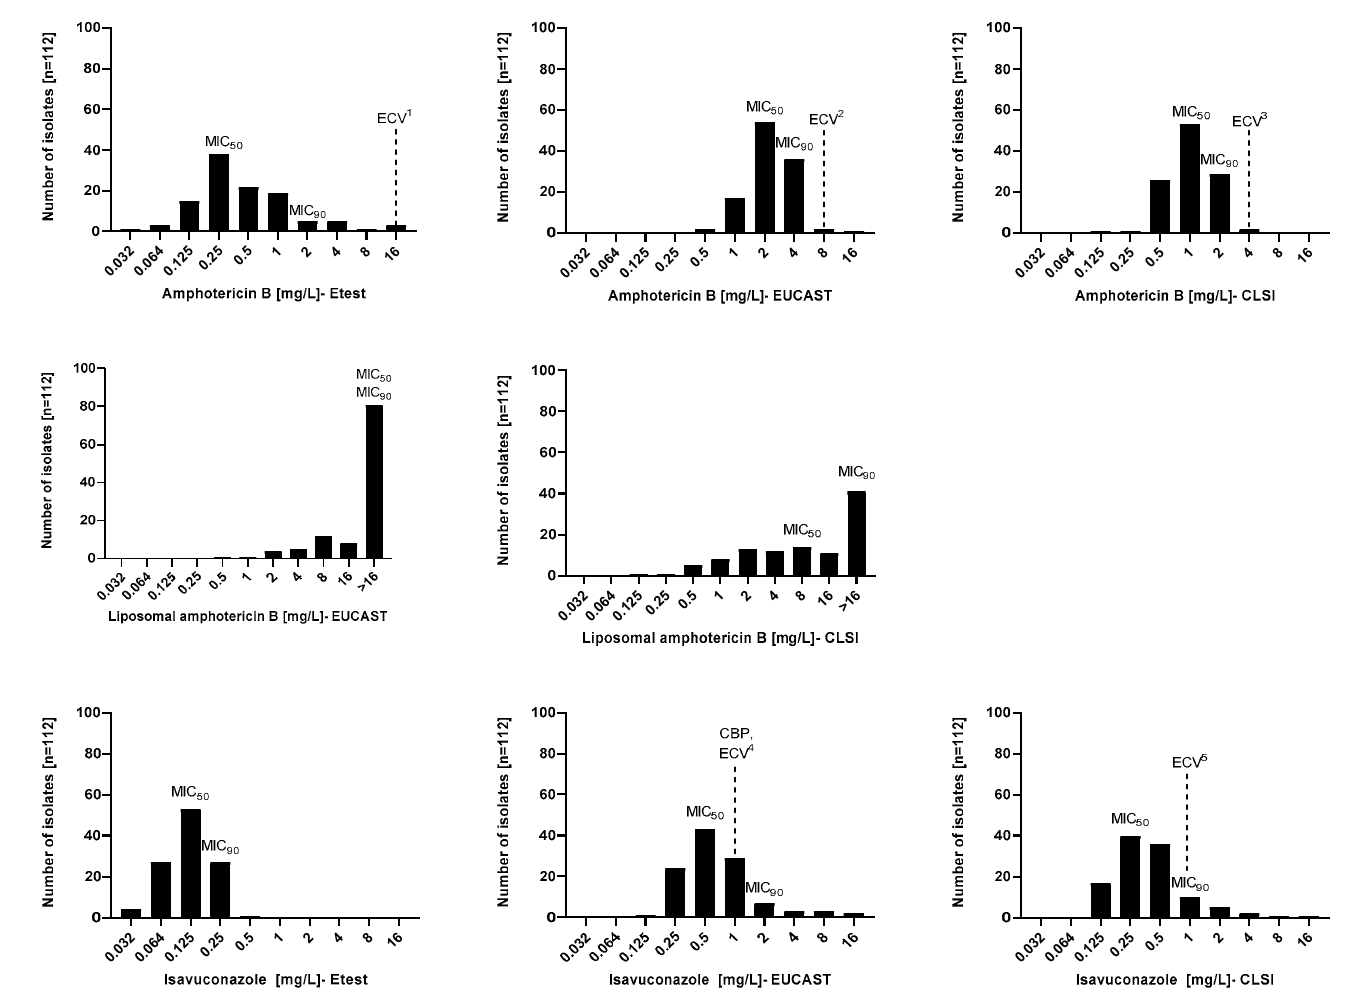
Figure 1. Minimalinhibitoryconcentration(MIC)distributionsofamphotericinB,liposomalamphotericin Figure 1. Minimal inhibitory concentration (MIC) distributions of amphotericin B, liposomal am- B, and isavuconazole performed by EUCAST, CLSI, and Etest methods against Aspergillus section Terrei